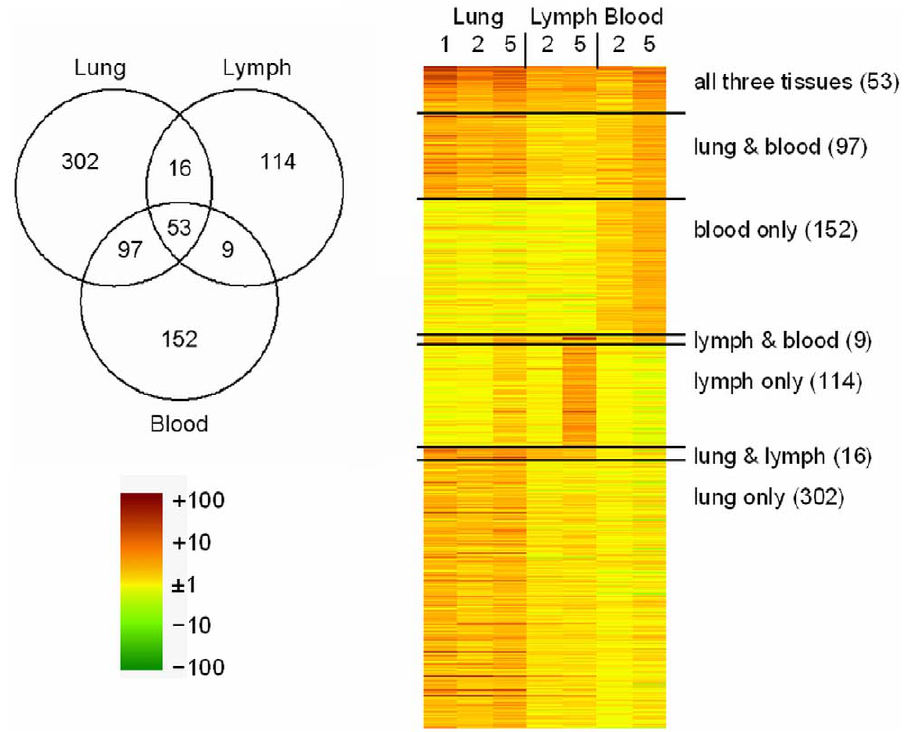
Figure 1. Comparison between lung, lymph node, and blood responses. The Venn diagram indicates the number of genes regulated in common or specific for each of the three tissues across any of the days examined. The heatmap indicates gene expression changes relative to the median of the unchallenged group on days 1, 2, and 5.